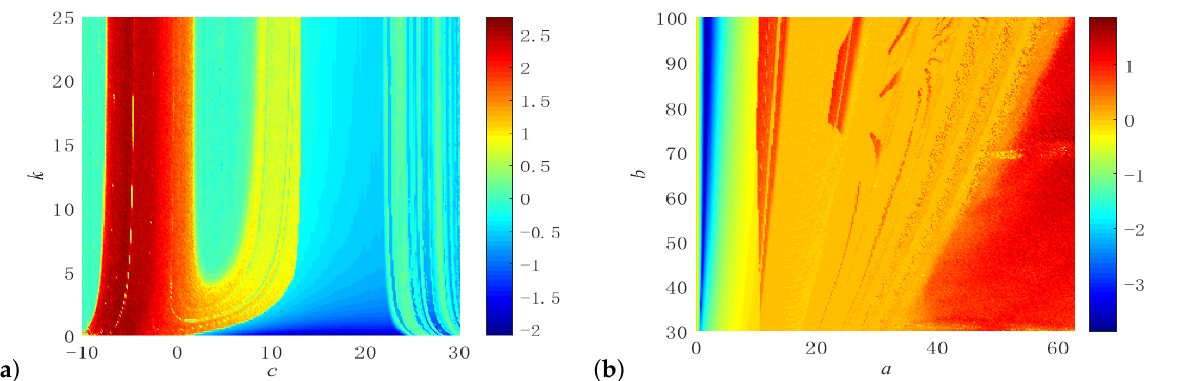
Figure 12. Diagram of largest Lyapunov exponents with different parameters: ( a ) division for parameters c and k ( a = 12 and b = 100) and ( b ) division for parameters a and b ( c = 10 and k =